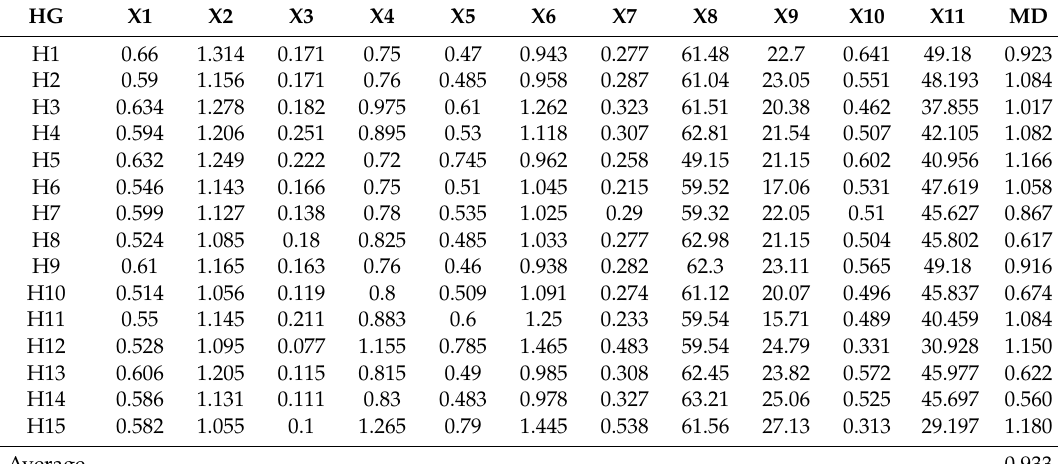
Table 7. MD of the healthy group (HG) data